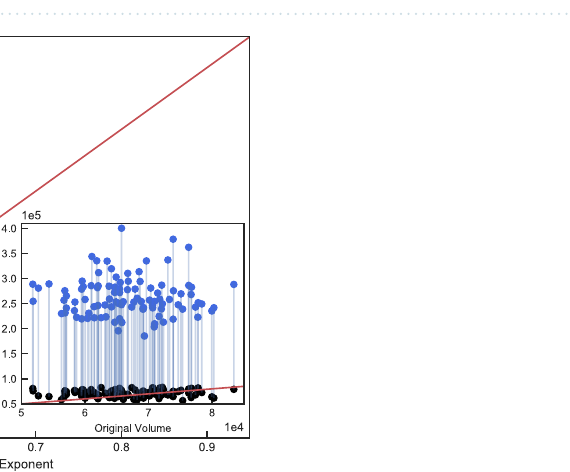
Figure 3. Chaotic to chaotic control. Top: 2D attractor representation in the x–y plane. Bottom: X coordinate time series. Left plots show the original chaotic state which changes to a different chaotic state (middle) after tuning the order parameter. After applying the control mechanism, the system is forced into the initial chaotic state again (right).